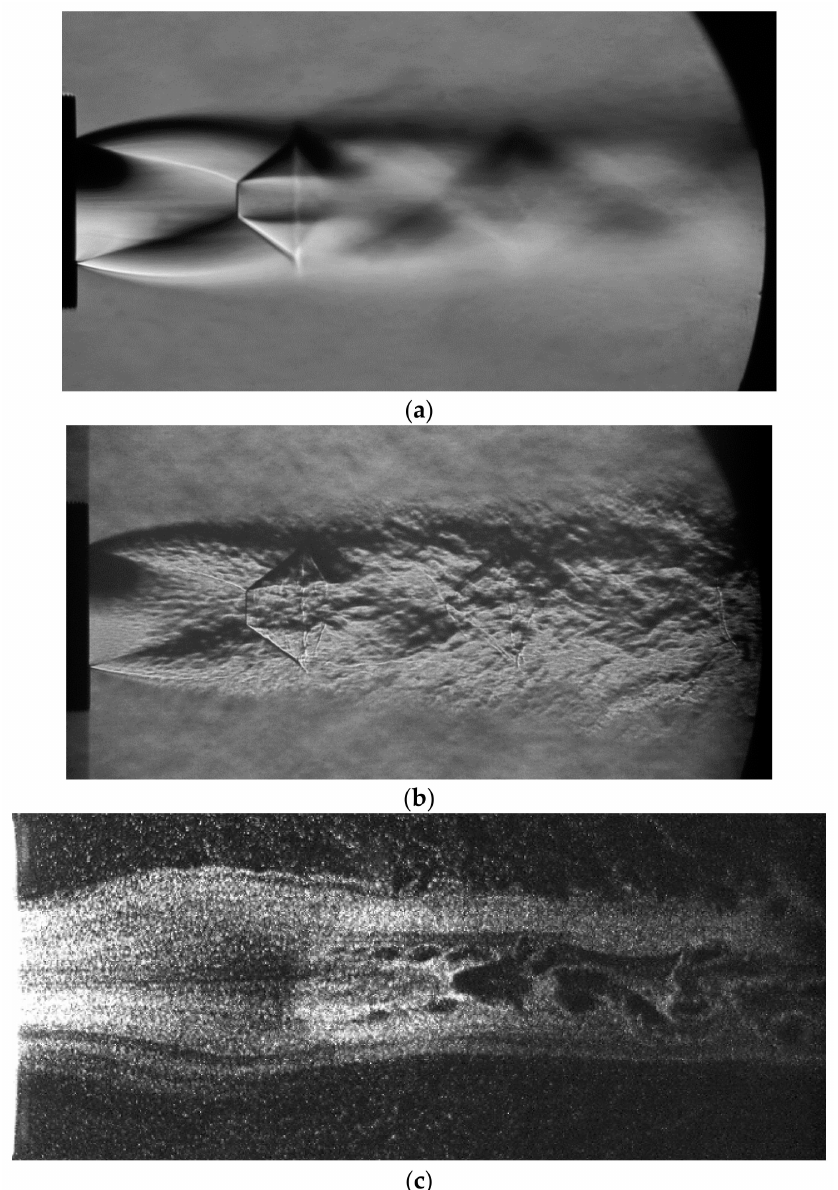
Figure 11. Photos of the initial length of a supersonic underexpanded jet, M a = 1.0, n p = 2.64: ( a ) exposure time 5 ms, horizontal knife; ( b ) exposure time 2 µ s, horizontal knife; ( c ) laser-knife visualization of the flow, exposure time 5